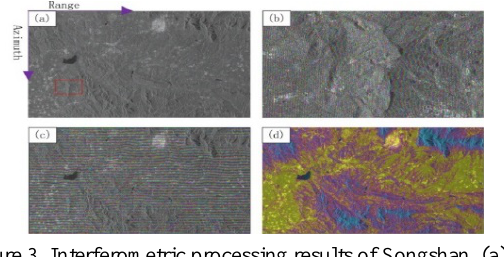
Figure 3. Interferometric processing results of Songshan. (a) is the interferogram map; (b) is a local large map of the red rectangular box in figure (a); (c) is the flattened interferogram map; (d) is the coherence